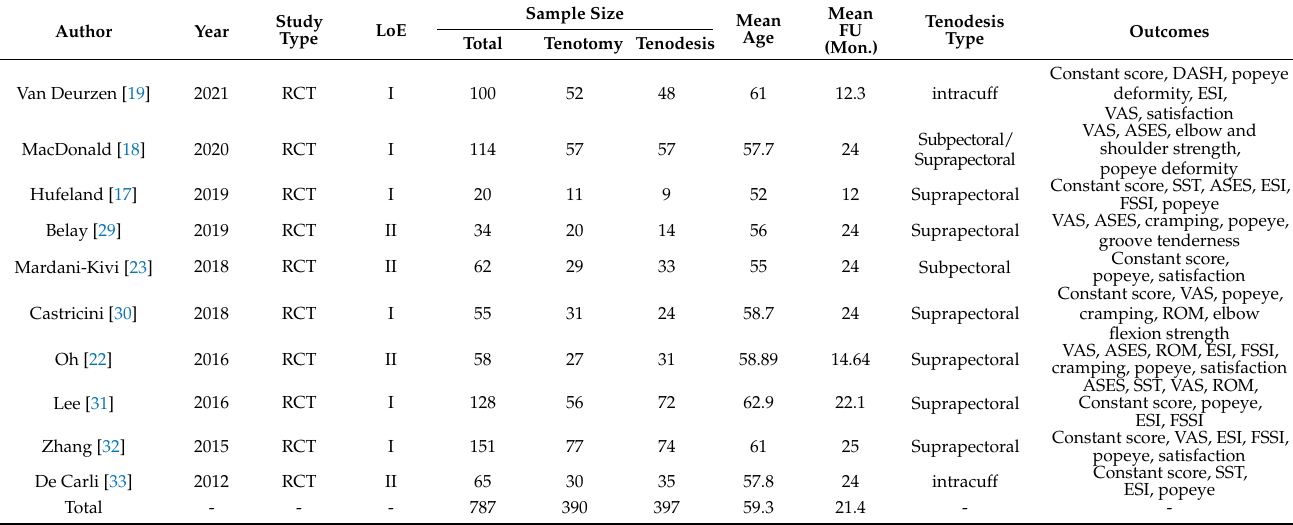
Table 1. Characteristics of the included